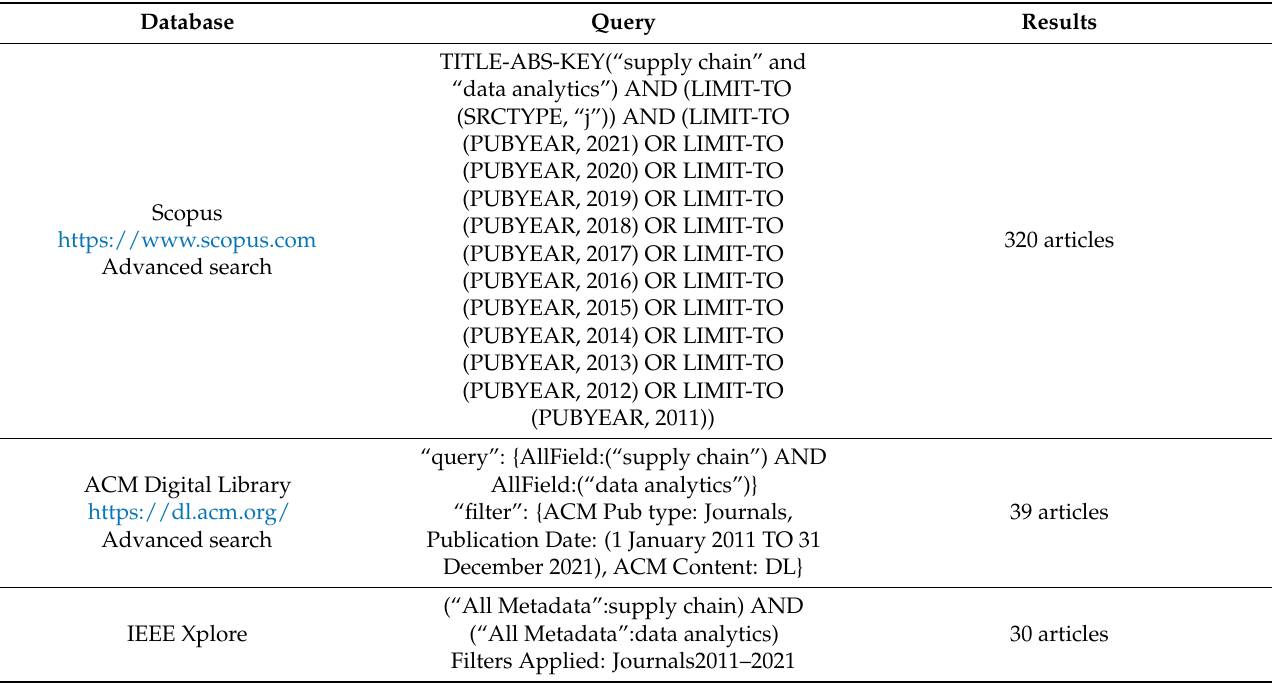
Table 2. Query strings used in each of the three databases.